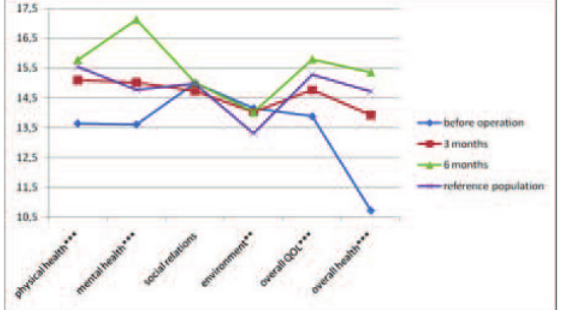
Figure 3. Comparison of WHOQOL-BREF score in morbidly obese patients 3 months after the operation according to sex